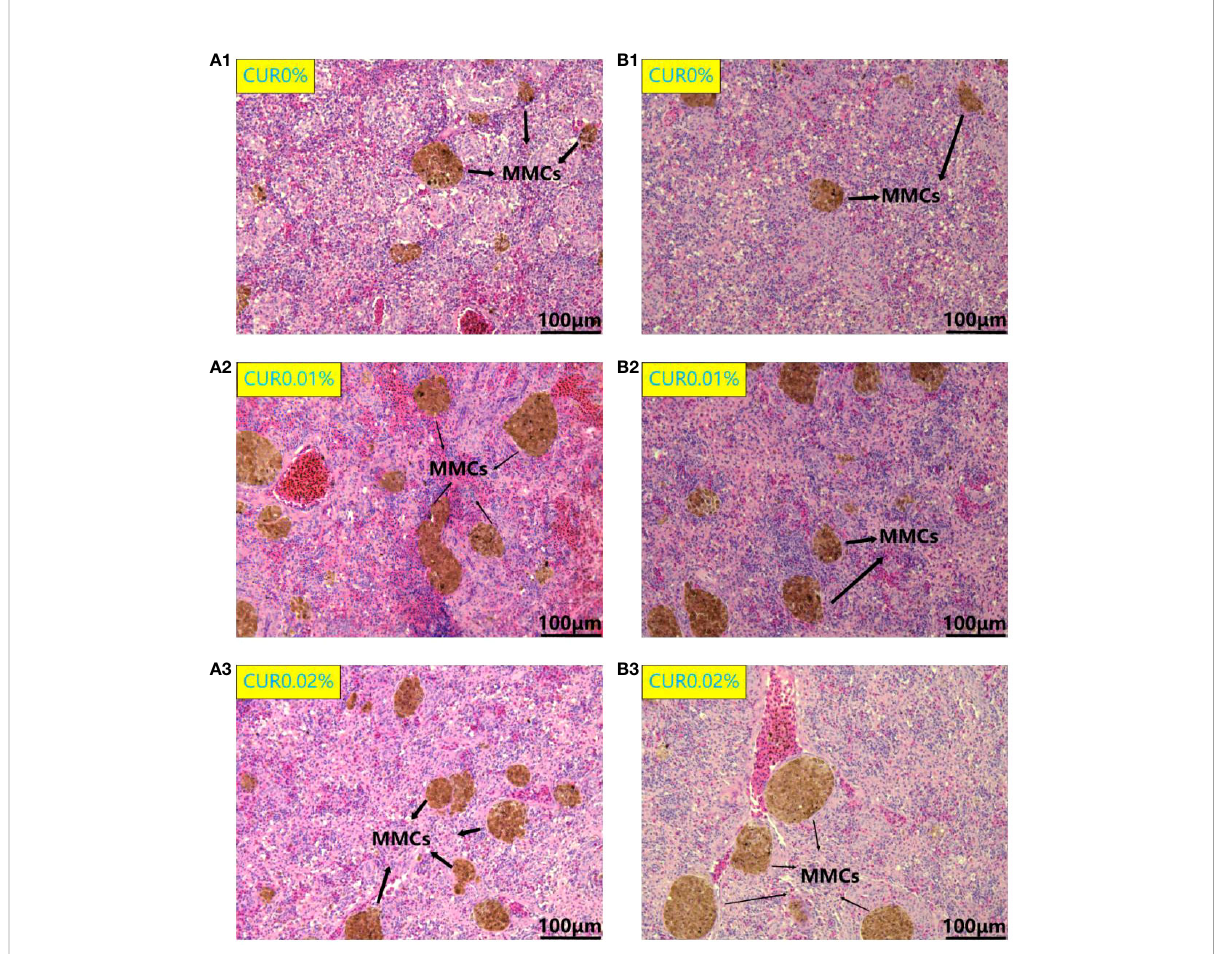
FIGURE 7 Spleen histological structure of different groups of the greater amberjack after ammonia challenge (A1 – 3) and after recovery (B1 – 3) . MMCs, melano-macrophage